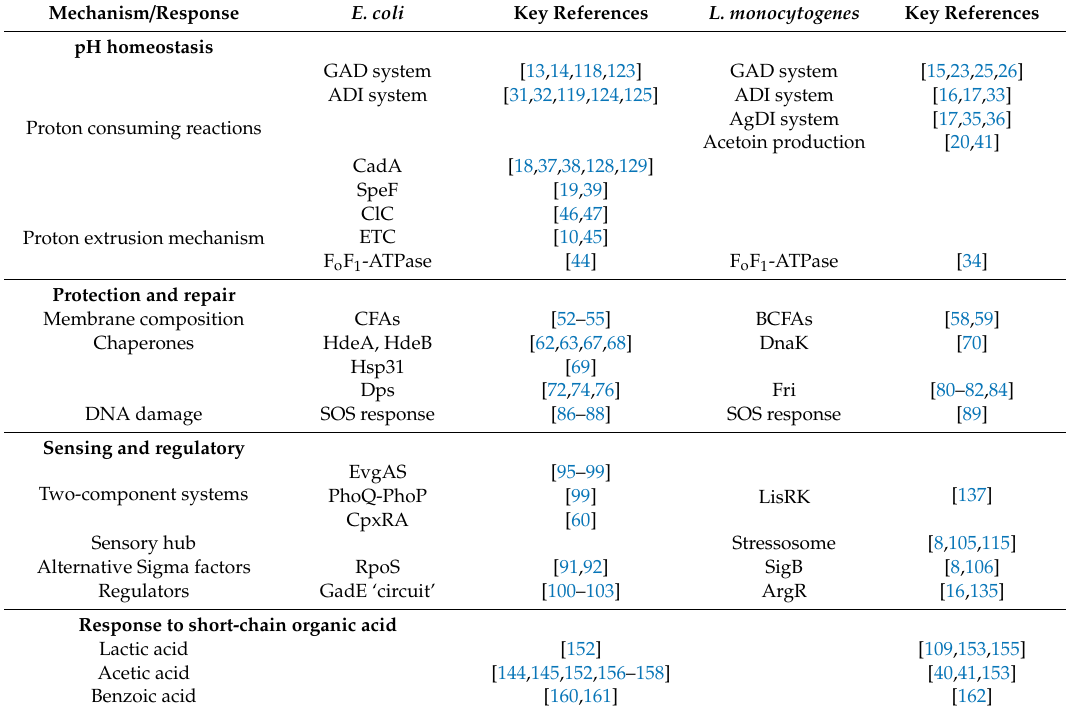
Table 1. Summary of mechanisms deployed by E. coli and L. monocytogenes to cope with acid